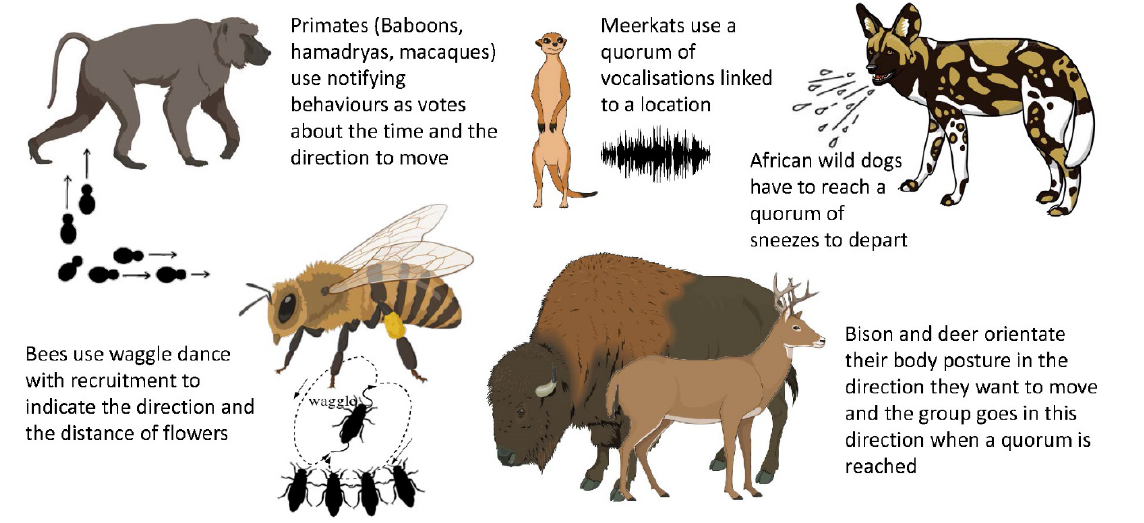
Figure 1: Species showing these different voting behaviours, specifically primates (Sueur, Deneubourg, et al. 2011; Strandburg-Peshkin et al. 2015), meerkats (Bousquet et al. 2011), African wild dogs (Walker et al. 2017), honeybees (Seeley 2010), bison (Ramos et al. 2015) and deer (Conradt, Roper